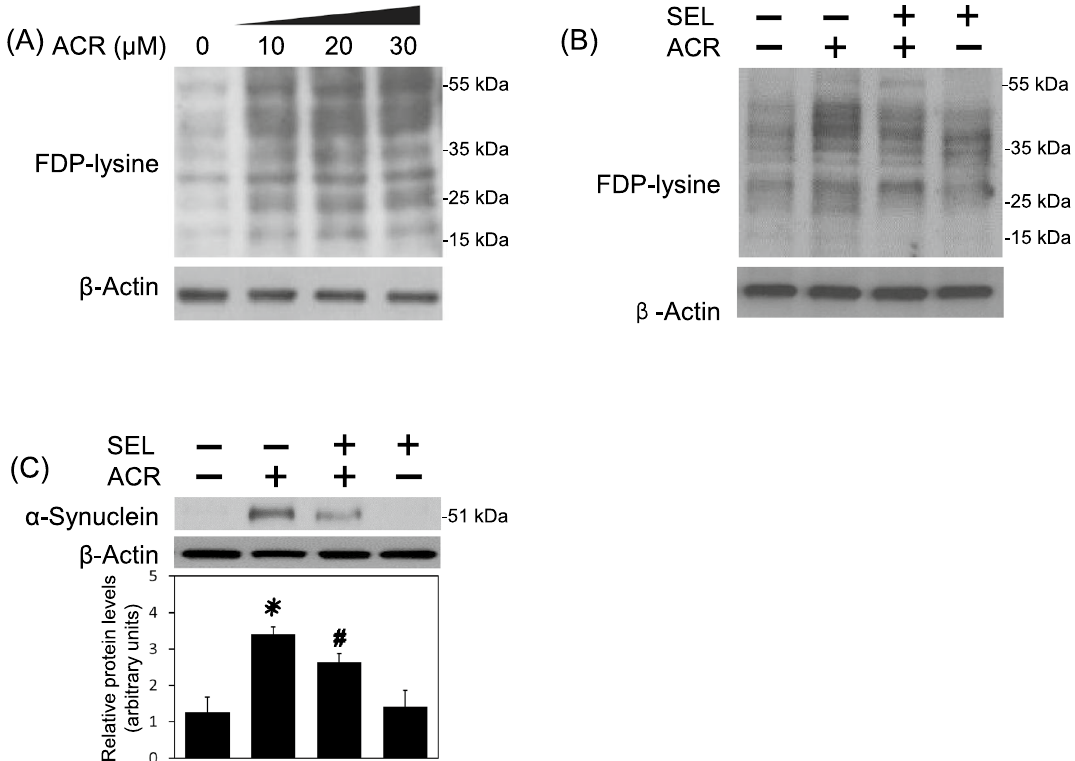
Figure 3. Effect of selumetinib on acrolein-induced protein conjugation and α-synuclein aggregation. ( A ) Primary cultured cortical neurons were treated with acrolein (0–30 μM) for 24 h. Western blot assay was employed to measure FDP-lysine. Each lane contained 25 μg protein for all experiments. Representative Western blot shows the effect of acrolein on FDP-lysine. Similar experiments were performed in duplicate. ( B , C ) Primary cultured cortical neurons were treated with acrolein (30 μM) with/without selumetinib (SEL, 10 μM) for 24 h. Western blot assay was employed to measure FDP-lysine ( B ) and α-synuclein ( C ), respectively. Each lane contained 30 μg protein for all experiments. Graphs show statistical results from relative optical density of bands on the blots. Values are the mean ± SEM. (n = 3/treatment). *p < 0.05 statistically significant in the acrolein groups compared with the control groups; # p < 0.05 statistically significant in acrolein plus SEL group compared with acrolein group by one-way analysis of variance (one-way ANOVA) and followed by the LSD test as post- hoc